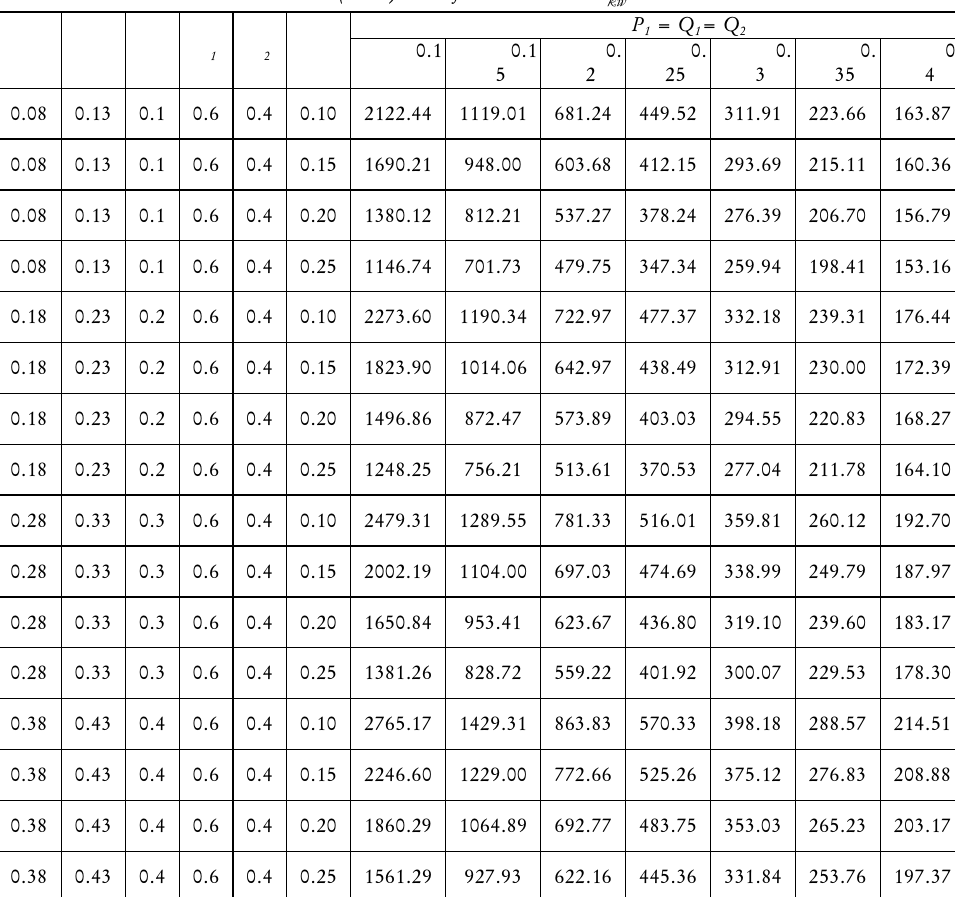
(2005) stratified estimator ˆ